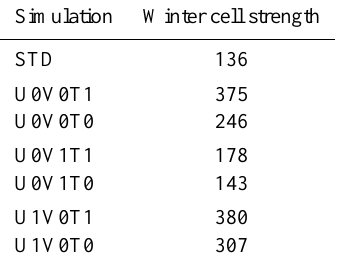
Table 3. Strength of the winter cell for seasonally varying insola- tion. Values represent the stream function maximum of the southern cell averaged between day 35 and 160 in units of 10 9 kgs − 1